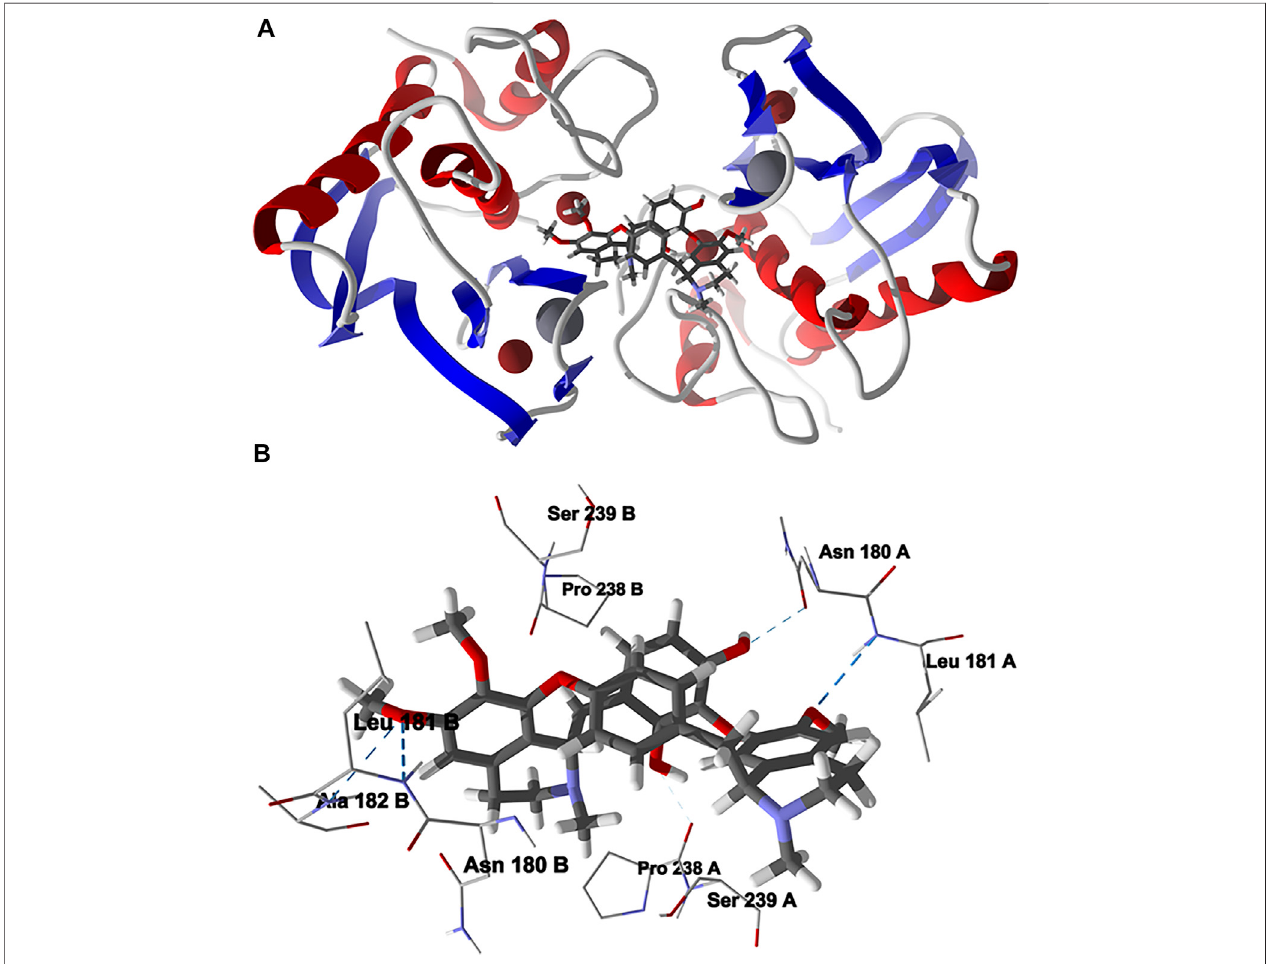
FIGURE 6 | Lowest-energy docked pose of chondrofolinol with human matrix metalloproteinase-1 (Hs MMP-1, PDB 1CGL). (A) : Ribbon structure (Zn 2+ ions are shown as dark red spheres, Ca 2+ ions are shown as gray spheres, and the docked chondrofolinol is shown as a stick fi gure). (B) : Active site showing the interactions of important contacts in the active site with the docked ligand (hydrogen-bonded interactions are indicated with blue dashed lines).